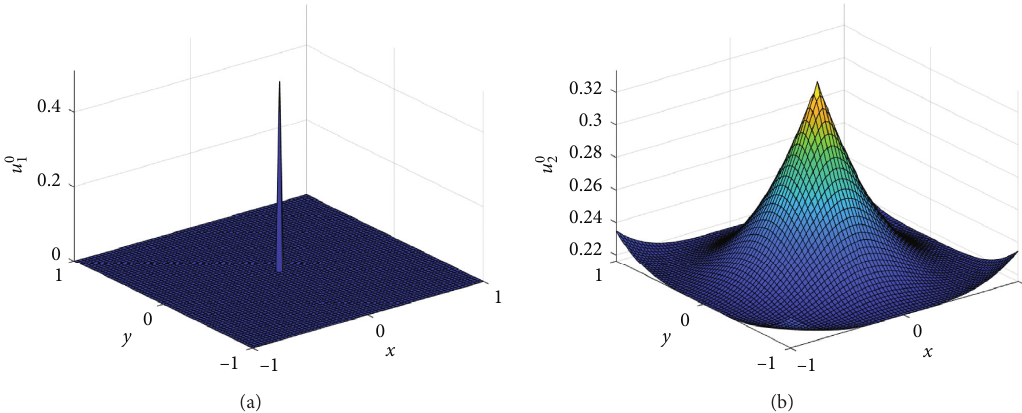
Figure 9: The initial values in (52) for the Gierer–Meinhardt model with ϵ � 0 . 04 at the mesh resolution Δ x � Δ y � 1/32: (a) u ( x, y, 0 ) (b) u 2